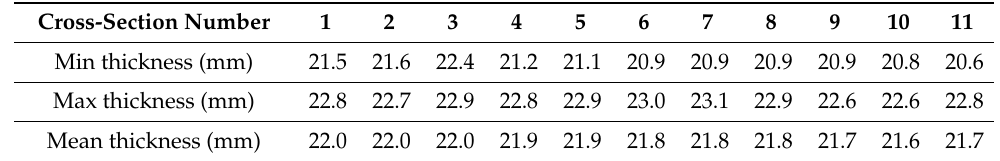
Table A3. Measured thickness of cylindrical pipe of pressure vessel—minimal, maximal and mean value of thickness in particular